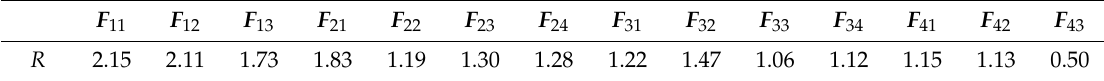
Table 10. The risk of the coupled risk